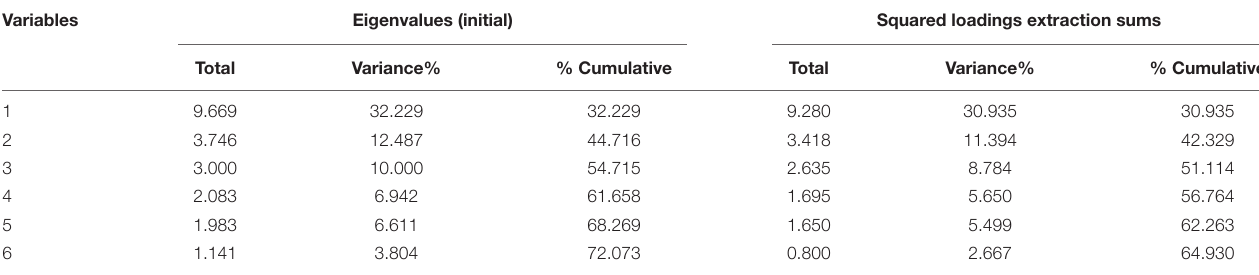
TABLE 8 | Cumulative variance and